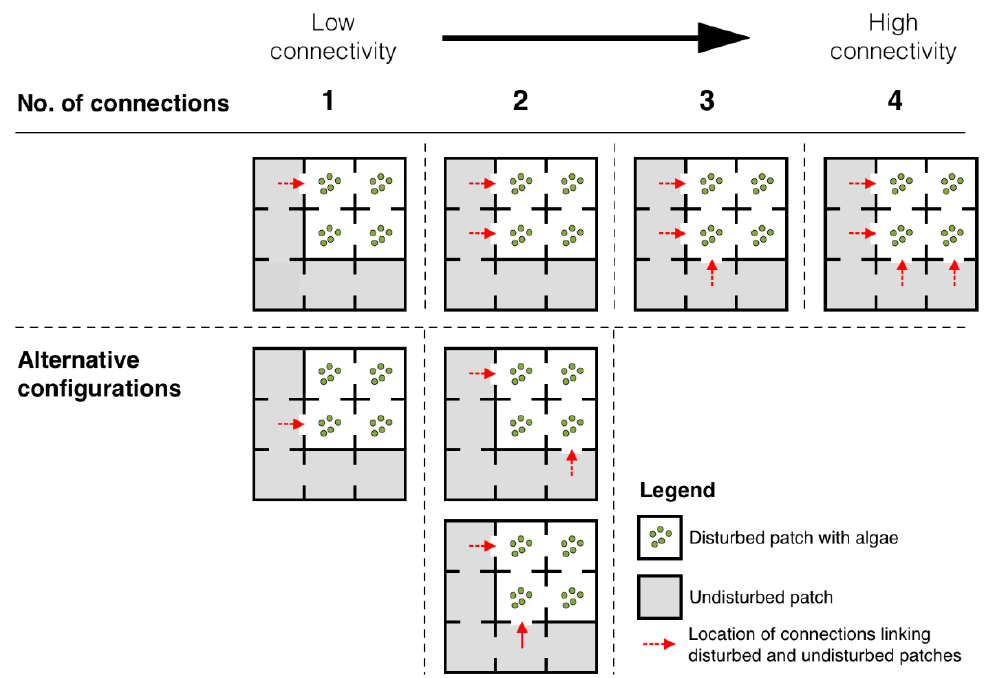
Figure 1. Experimental microcosms with different levels of connectivity that did not mirror each other. Connectivity increases with respect to an increasing number of links between the undisturbed and disturbed part of the system, and with respect to alternative spatial configurations for a given number of links.